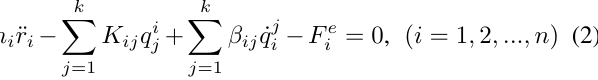
and fold it along a curve of arbitrary shape, i.e., the user can set their own bars on the object. The extension of Coquillart originated the name Extended Free Form Deformation of (EFFD)